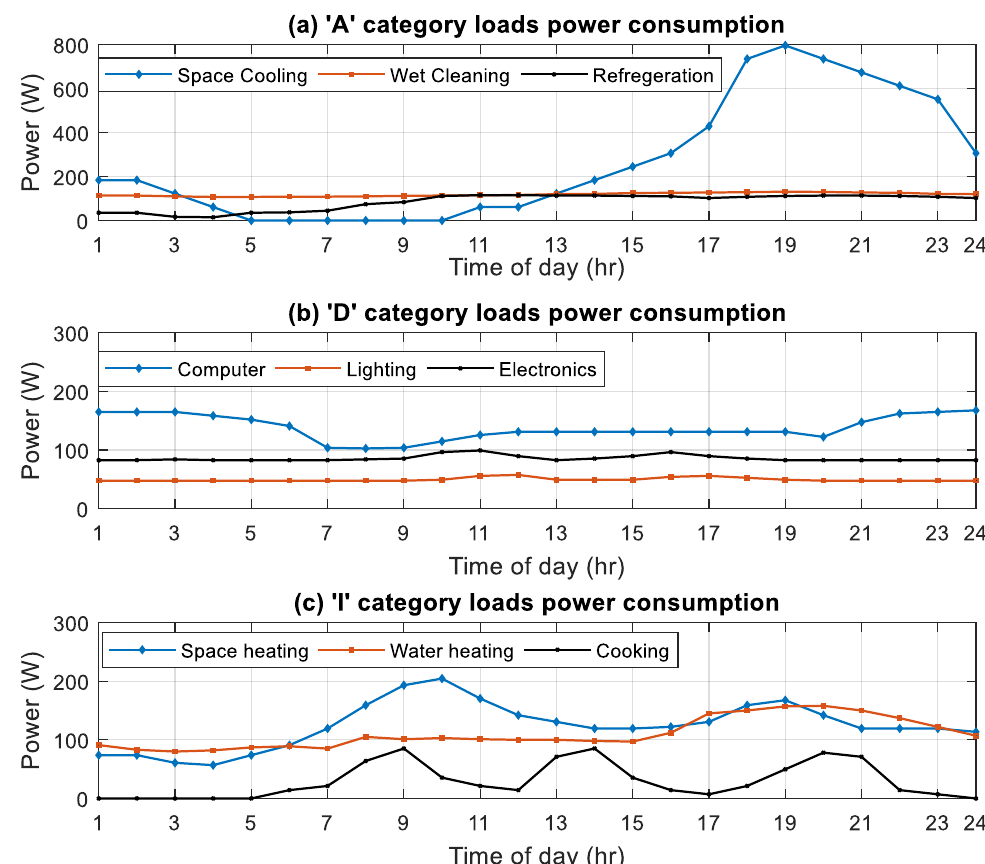
Figure A1. Hourly power consumption under different load categories: ( a ) ‘A’ category loads, ( b ) ‘D’ category loads, and ( c ) ‘I’ category loads.